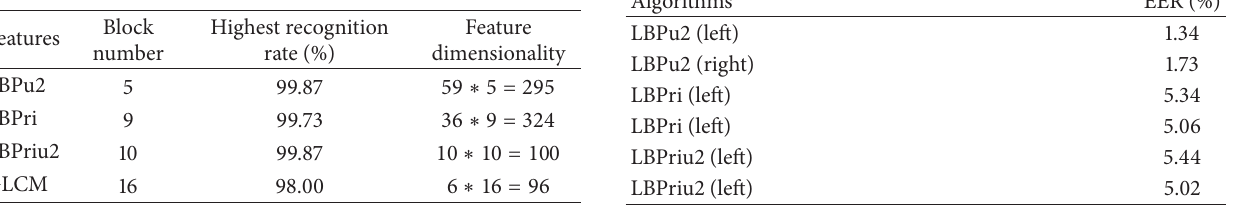
Table 5: Block selection using the contribution of block location by looking at the recognition rate of each block position.